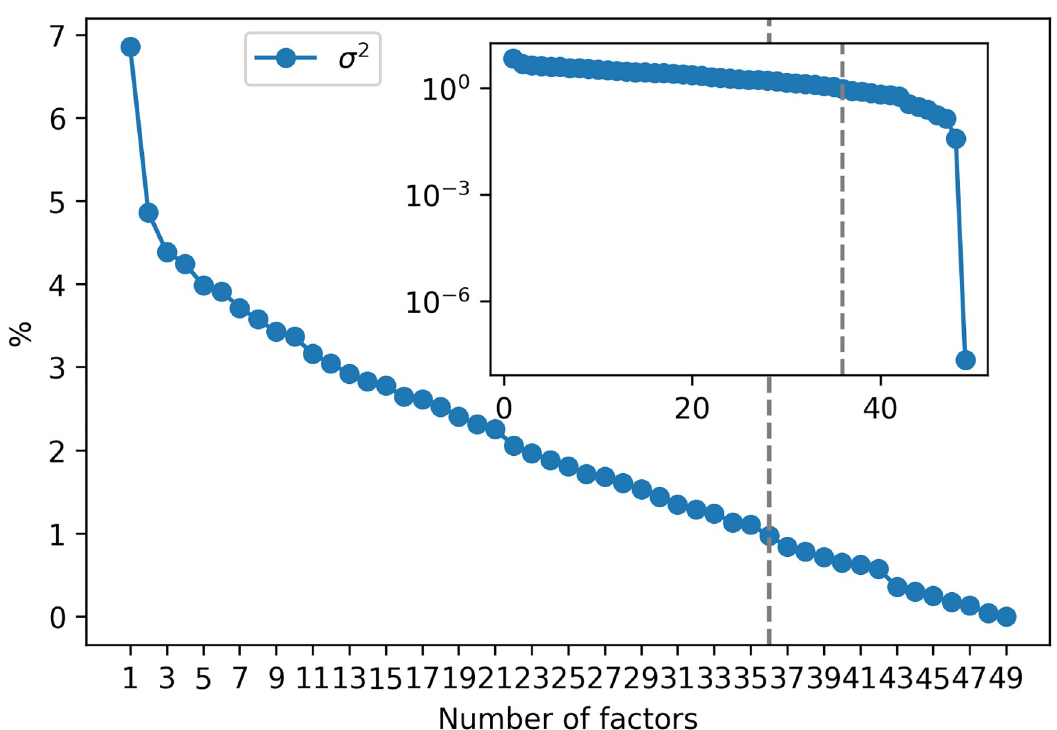
Fig 6. Explained variance in CCA. Percentage contribution to variance as a function of the component. The inset graph show the same but on a semi-log